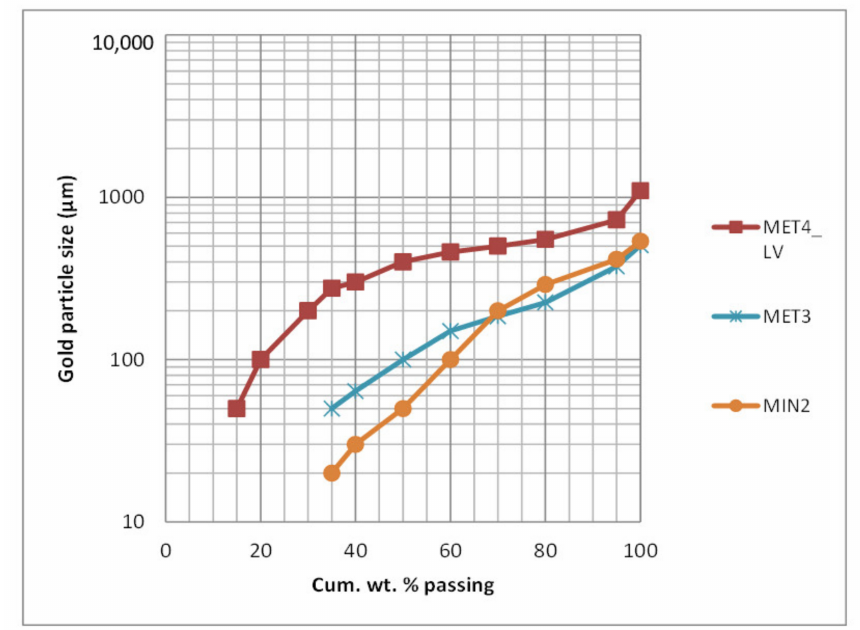
Figure 15. Gold particle size curves no visible gold weakly LV mineralisation (MET3 and MIN2). LV MET4 (ROM grade) data included for